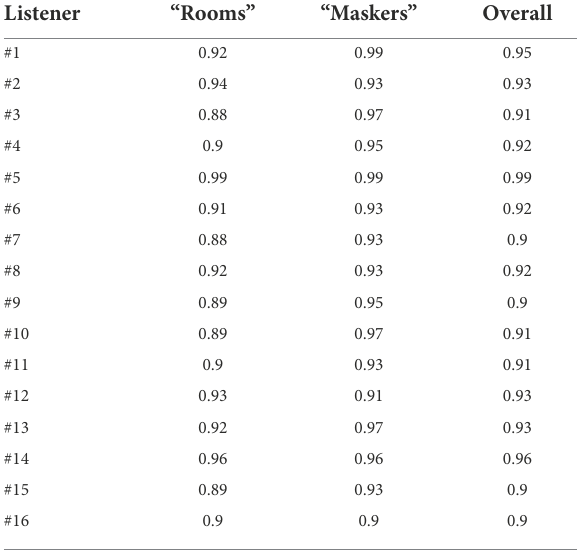
TABLE 3 Individual test–retest PCC for each of the 16 listeners.